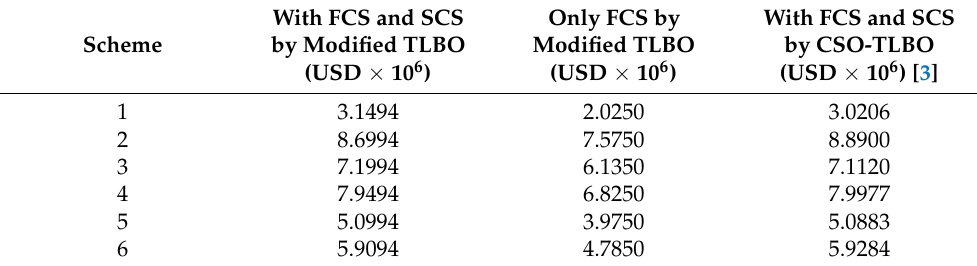
Table 7. Objective function cost value comparison for the different planning schemes.